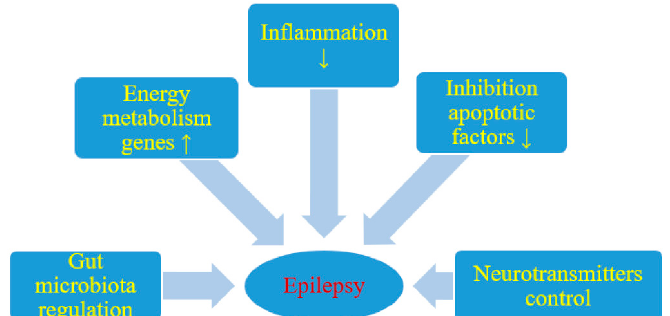
Figure 1. Likely effect of a ketogenic diet on seizure activity; ↑ increase, ↓ decrease. Figure 1. Likely e ff ect of a ketogenic diet on seizure activity; ↑ increase, ↓ decrease. Reproduced